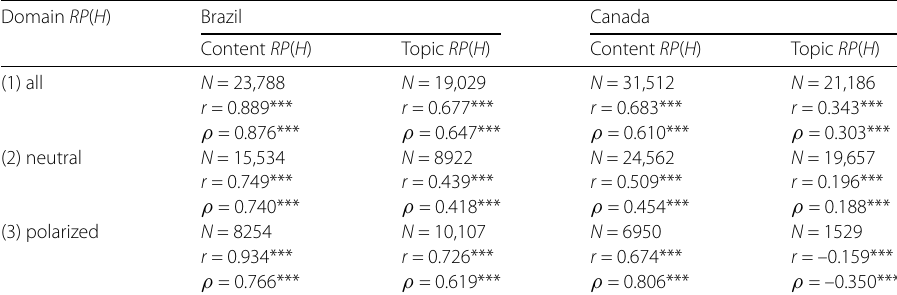
Table 6 Correlation between retweeted Domain RP ( H ) and Content or Topic RP ( H ) Domain RP ( H